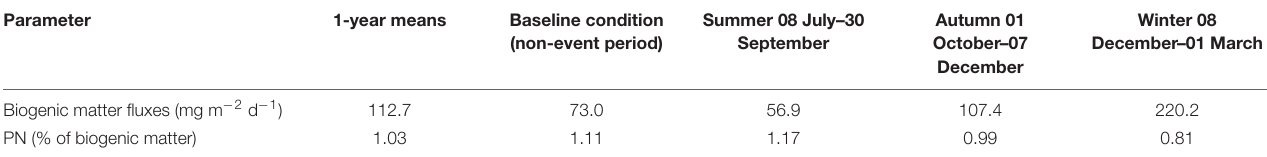
TABLE 4 | Biogenic matter fluxes in sinking particles (calculated as sum of organic matter, CaCO 3 , and opal fluxes) and particle composition of particulate nitrogen (PN) in biogenic matter fluxes during different seasons of 2014–2015. Parameter 1-year means Baseline condition (non-event